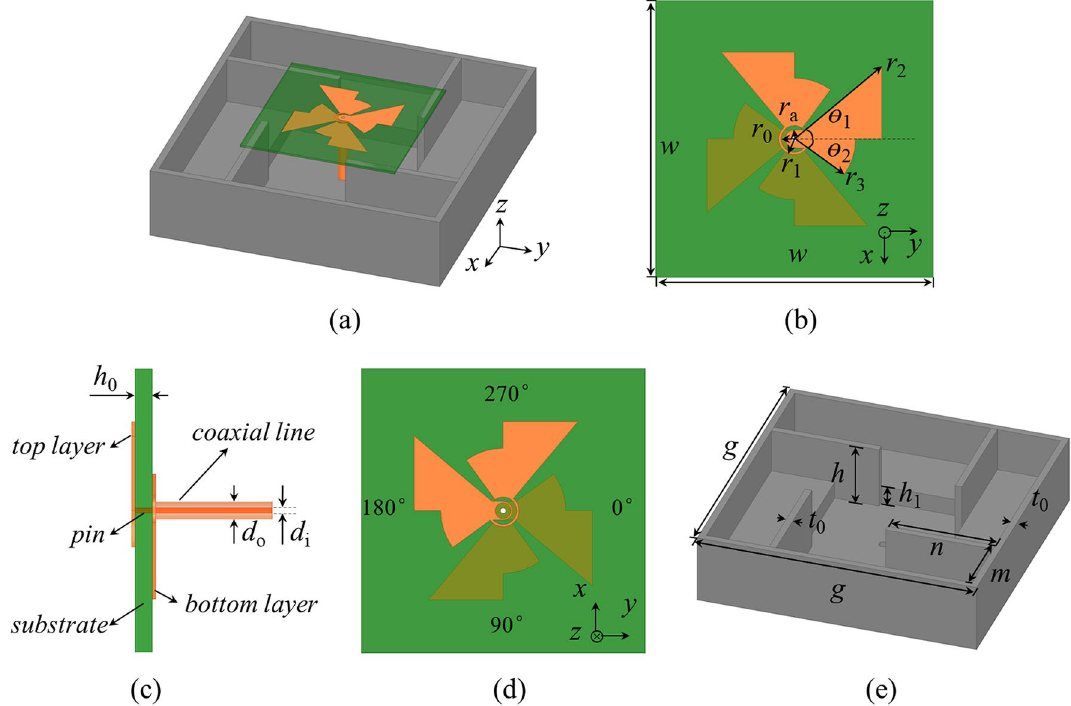
Figure 1. Schematic illustrating the proposed CP antenna. ( a ) 3D view of the proposed CP antenna. ( b ) Top view of the crossed-dipole. ( c ) Side view of the crossed-dipole. ( d ) Bottom view of the crossed-dipole. ( e ) 3D view of the modified